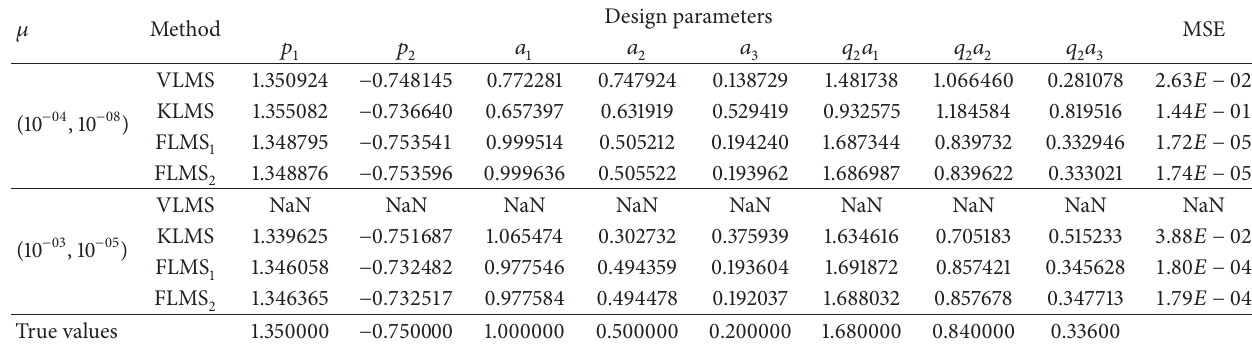
Table 3: Comparison of proposed results against true values of INCAR model for 10dB SNR.